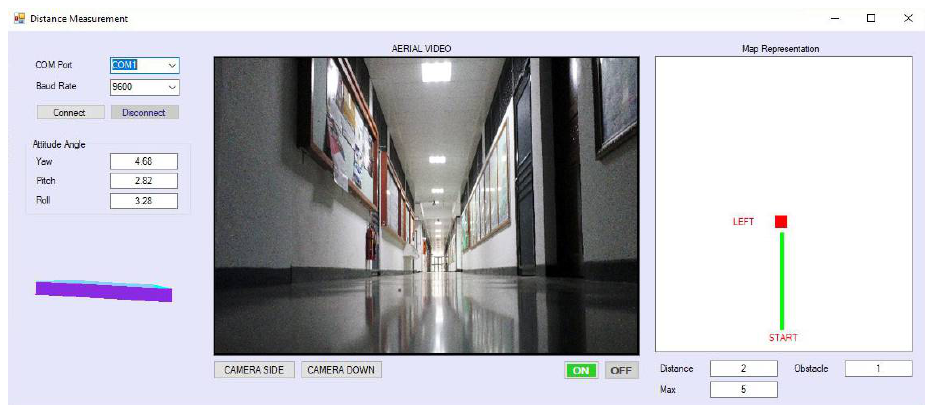
Figure 8. User interfaces for UAV monitoring.